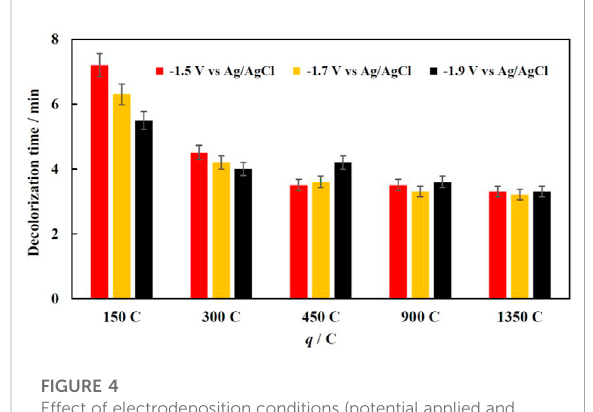
FIGURE 4 Effect of electrodeposition conditions (potential applied and charge passed) on decolorization time of 70 mg/L MO solution at 30 °